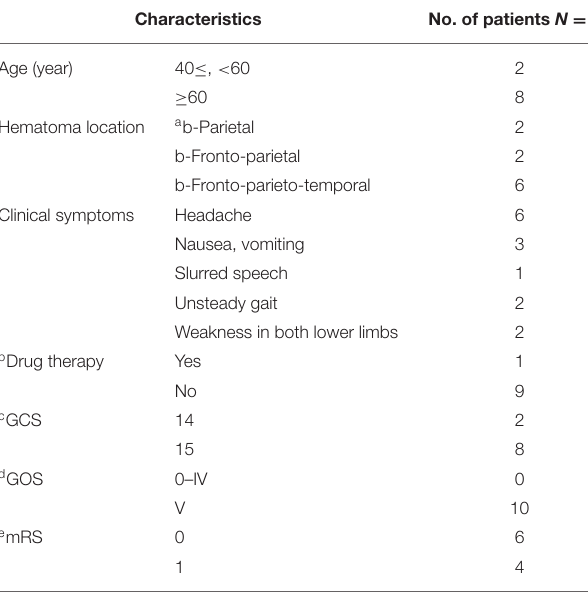
TABLE 1 | Baseline characteristics and prognoses of patients with bilateral chronic subdural hematoma. Characteristics